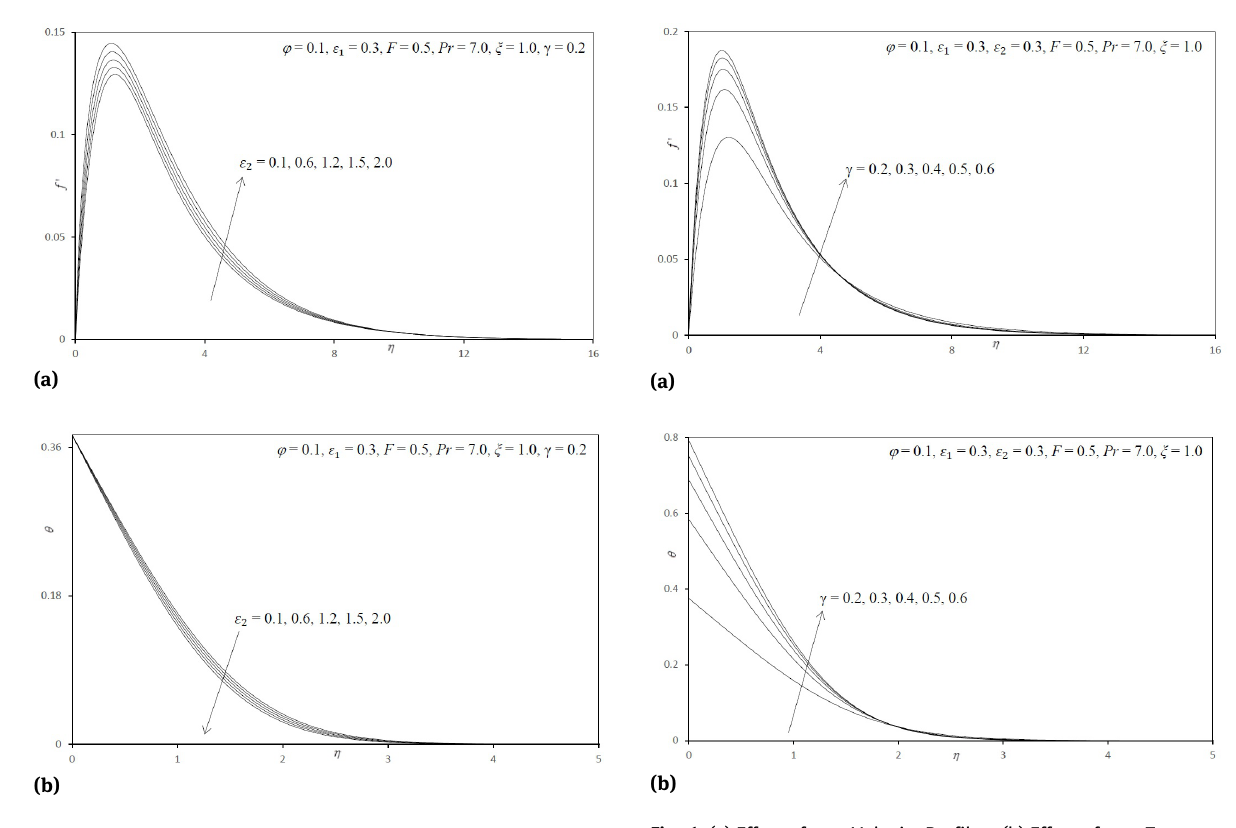
Fig. 5: (a) Effect of ϵ 2 on Velocity Profiles; b) Effect of ϵ 2 on Tempera- ture Profiles